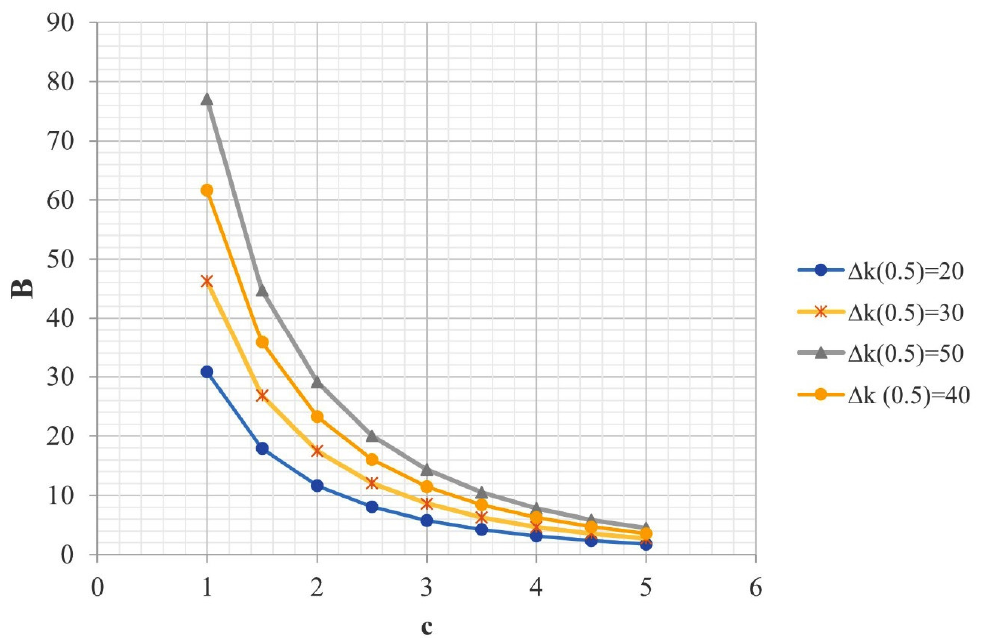
Figure 7. The relationship of constants B and c in Equation Figure 7. The r elationship of constants B and c in Equation (6).